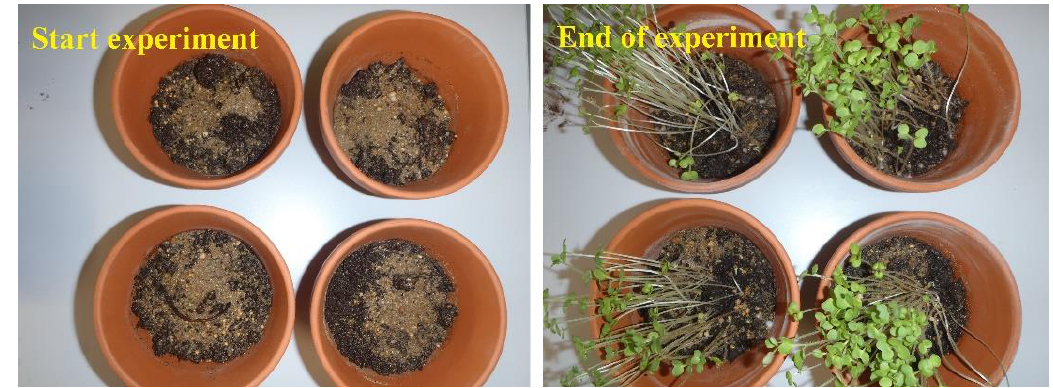
Figure 4. Illustration of the plant biomass of Sinapis alba L. and Hordeum vulgare L.